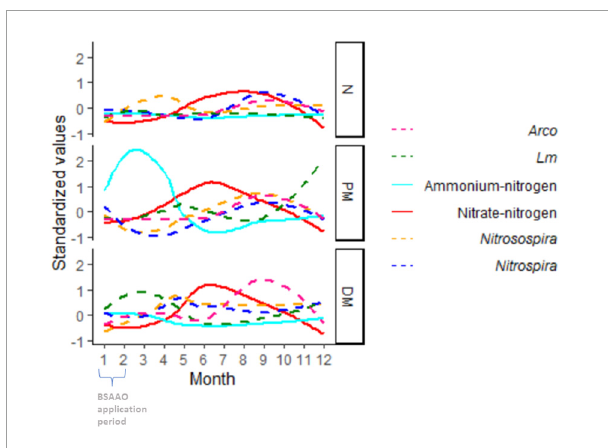
FIGURE7 Seasonal Trends in Lm and Arcobacter ( Arco ) prevalence, Nitrosospira relative abundance, Nitrospira relative abundance, ammonium-nitrogen and nitrate-nitrogen levels in Ohio soil, grouped by soil amendment. All variables are standardized to the same scale using the R standardize function in the robustHD package. BSA, biological soil amendment; BSAAO, biological soil